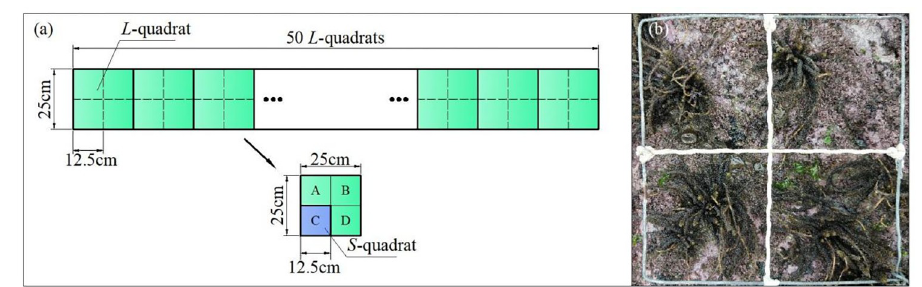
Fig 1. Macroalgae survey methodology and quadrat layout. (A) Fifty L -quadrats containing 200 S -quadrats were successively placed along the transect line, (B) the occurrence times of species by the Binary Method.